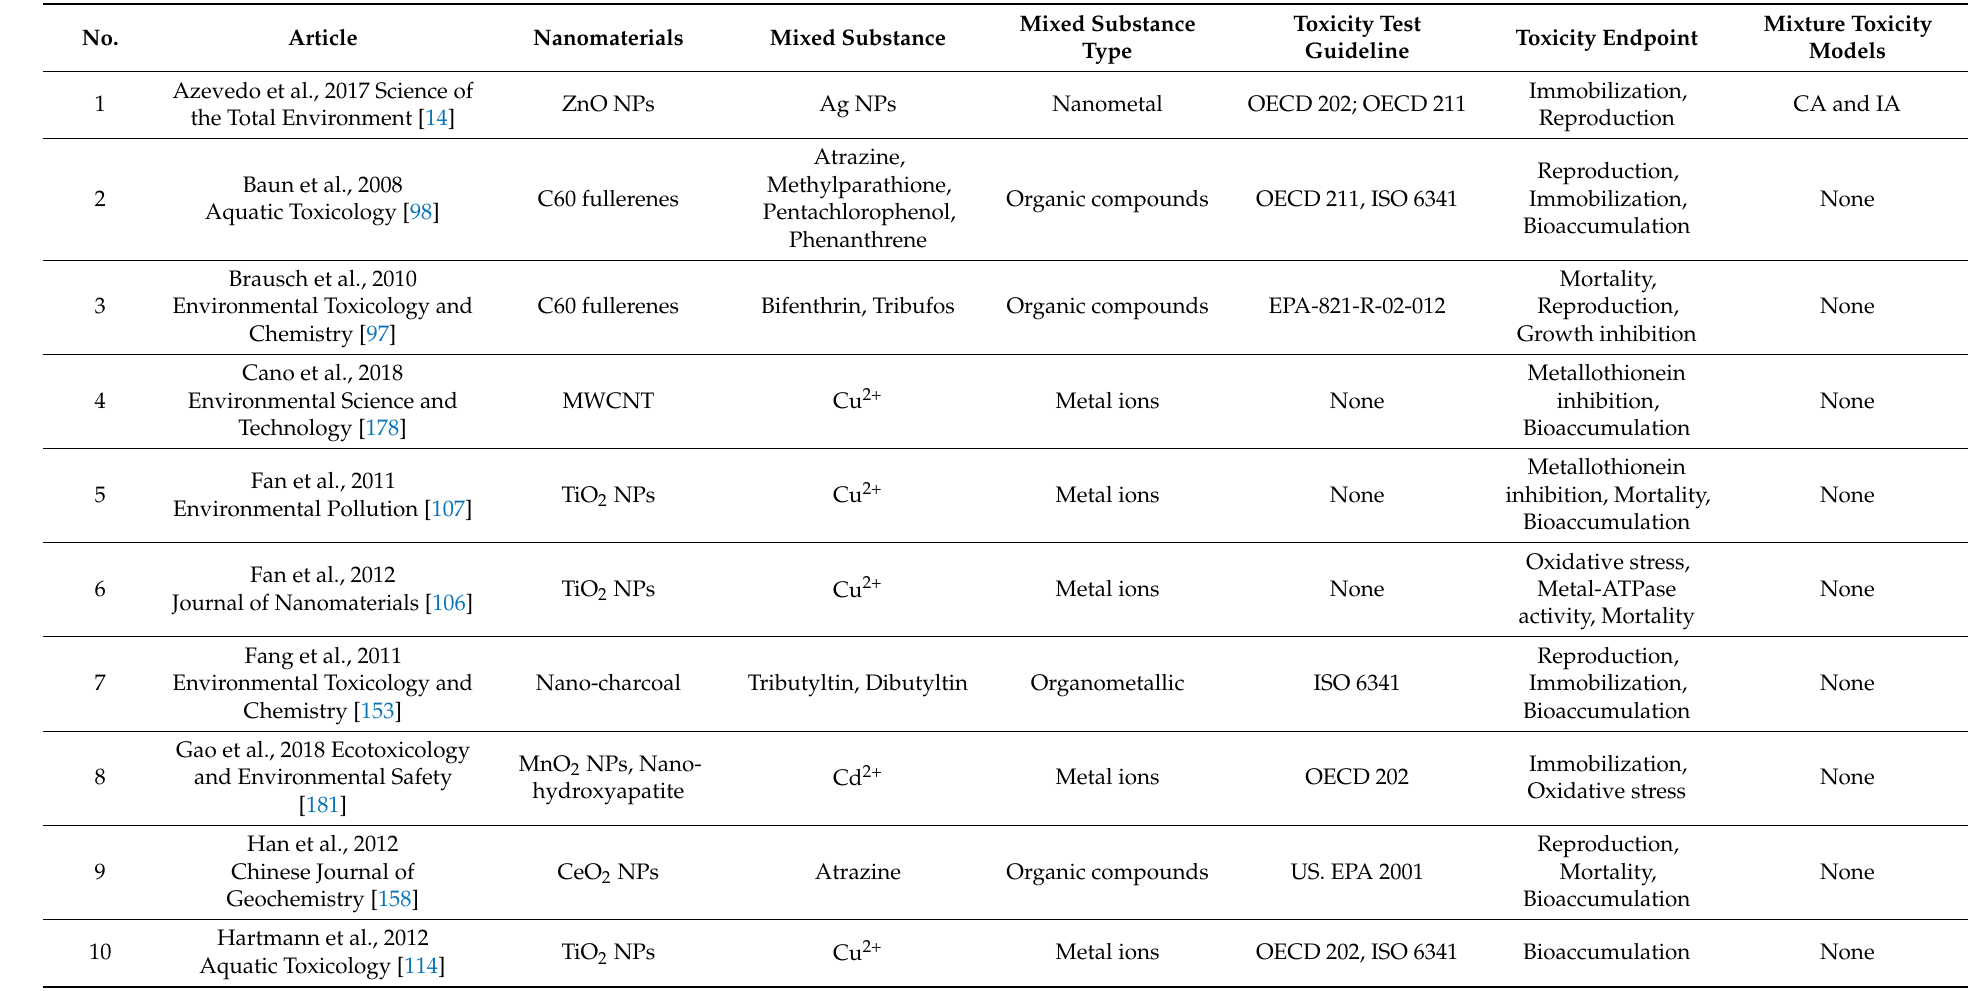
Table 2. Summary of current nano-mixture toxicity data for D. magna (CA: Concentration Addition, IA: Independent